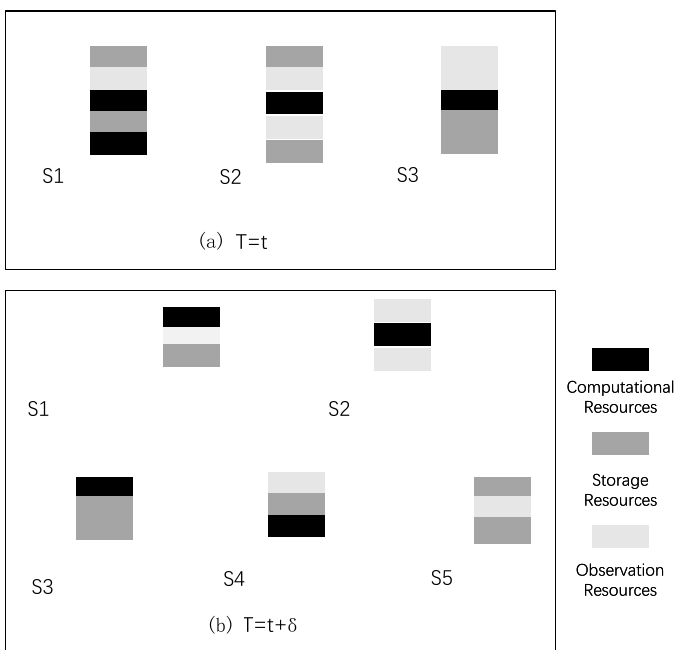
Figure 3. Schematic figure of autonomous reconstruction of resource request queue on a spatial information network.